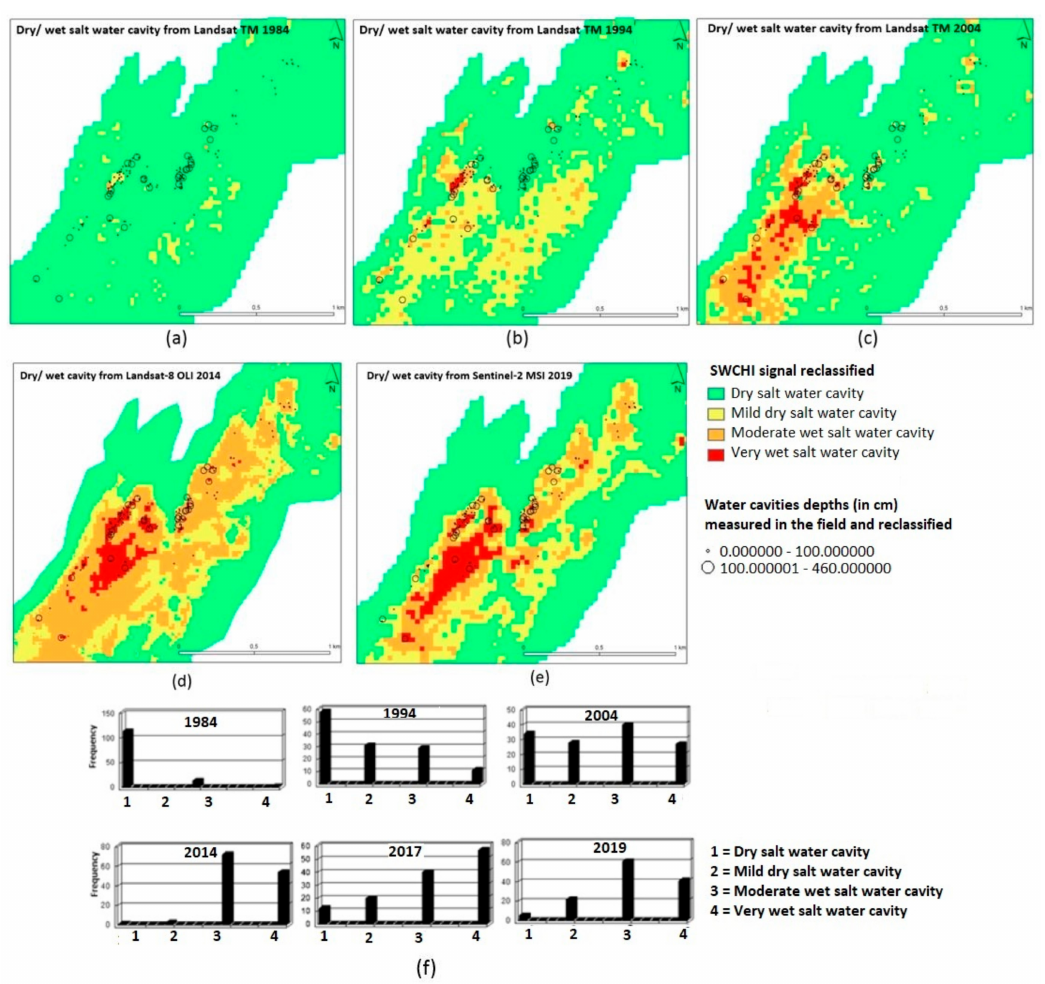
Figure 8. ( a – e ) SWCI signal reclassified into four classes from dry to very wet saltwater cavities from 1984 to 2019 versus the depth of the saltwater cavities measured in the field and reclassified into two classes, and ( f ) wet / dry state statistics of the saltwater cavities extracted from the classified